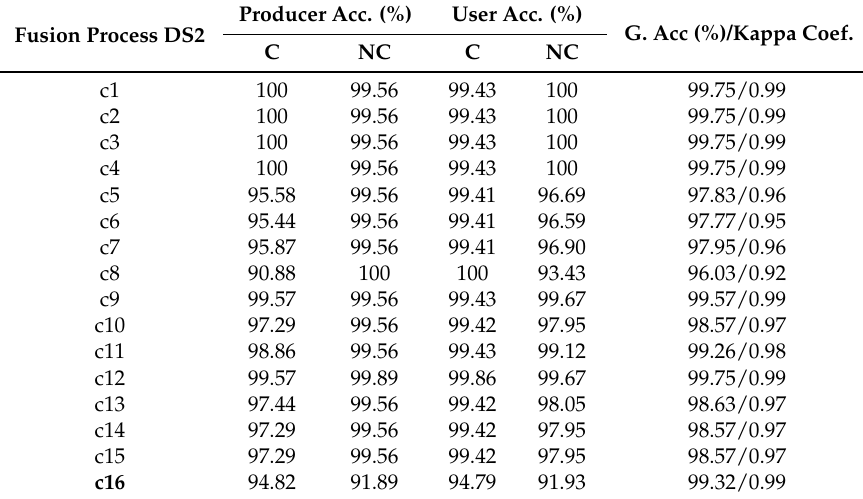
Table 11. DS2, Accuracy analysis of the Probabilistic Information Fusion process.